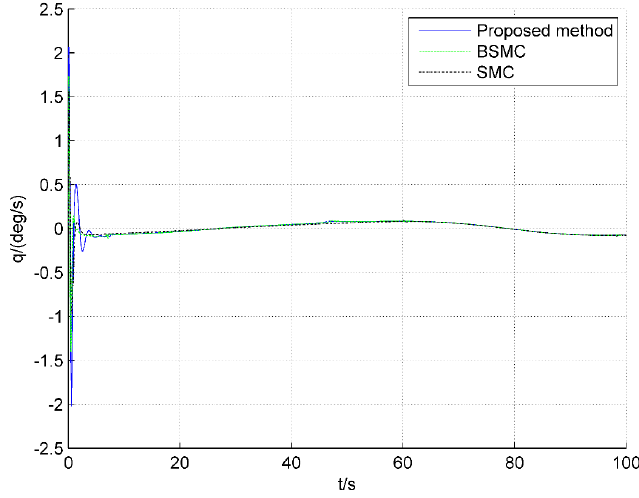
Figure 9. Responses of pitch angle rate.